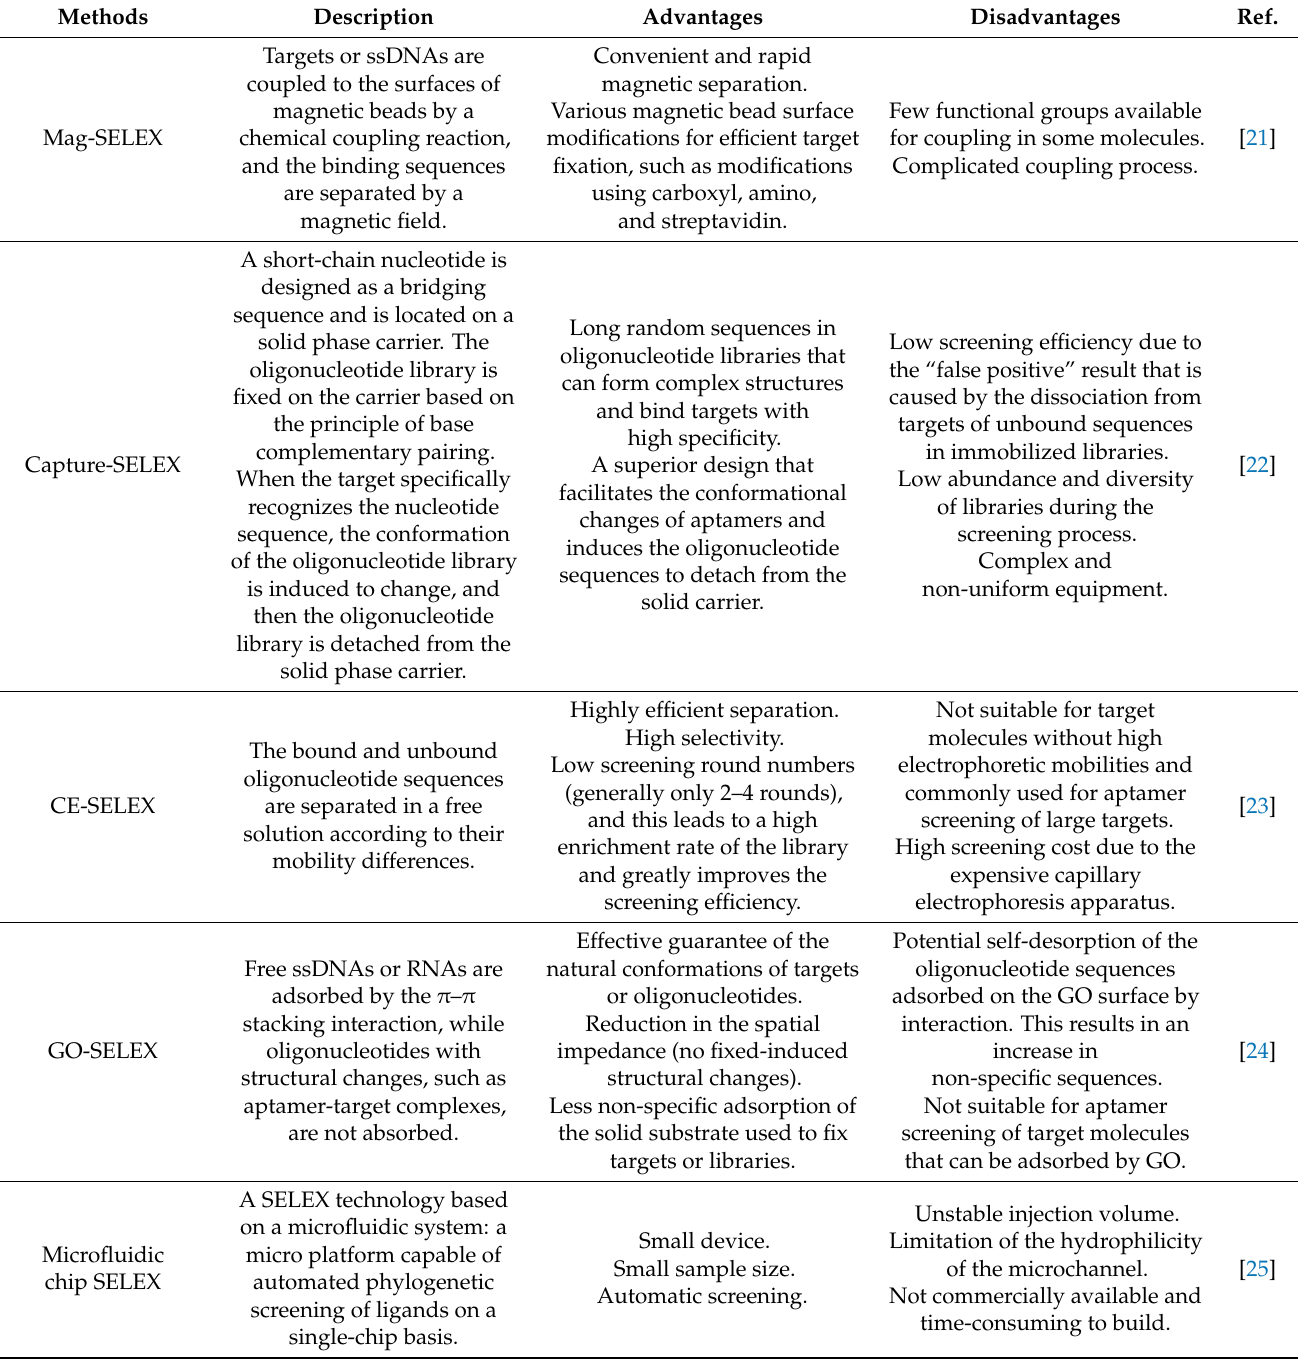
Table 1. Summary of aptamer screening